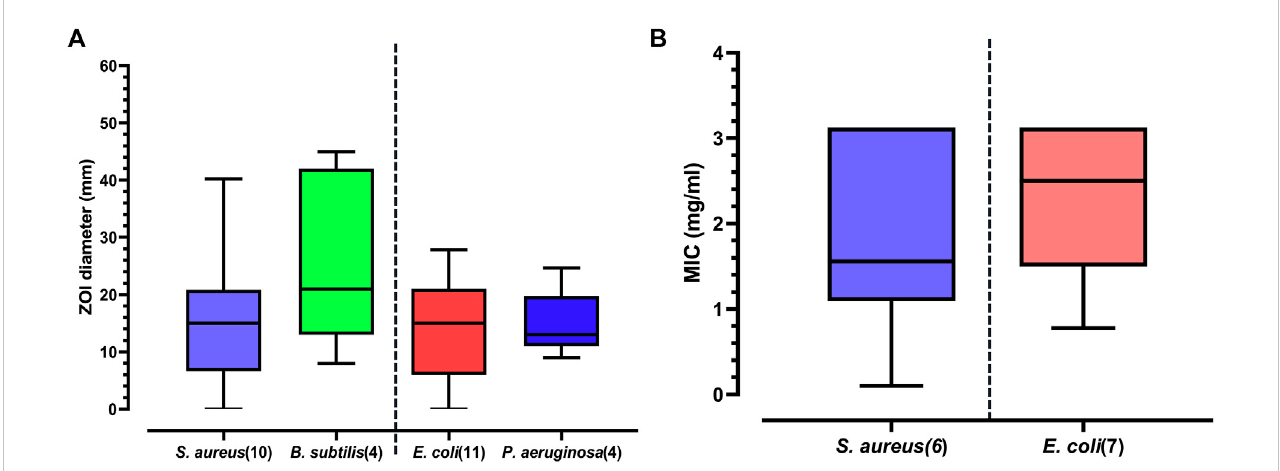
FIGURE 4 (A) Boxplot of pooled median ± range of zone of inhibition (ZOI) results reported in included studies against four pathogens gram positive: S. aureus , B. subtilis and gram negative: E. Coli , P. aeruginosa (values in parentheses indicate number of studies). (B) Boxplot of pooled median ± range of minimum inhibitory concentration (MIC) results reported against S. aureus and E. Coli in included studies (values in parentheses indicate number of